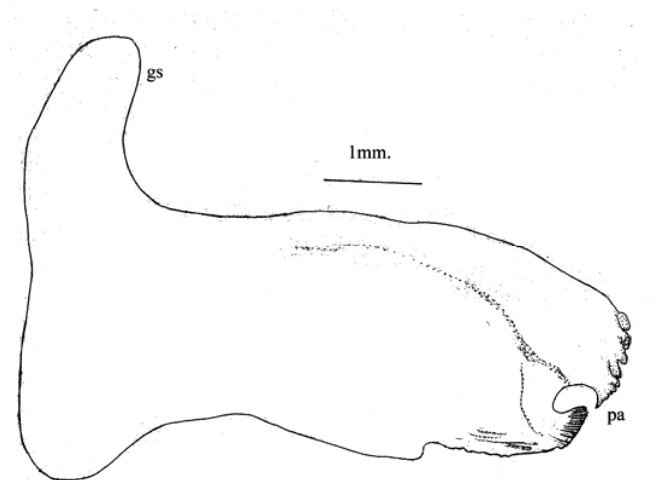
F IG .5.- Terminal abdominal segments of the imago of Myrmecaeurus trigrammus ,showing pleuritosquamae attached on 6 th and 7 th segments.pls; pleuritosquamae, t6,t7,t8,t9; tergum 6 through 9, ect; ectoproct, s6,s7,s8,s9 ; sternum 6 through 9.